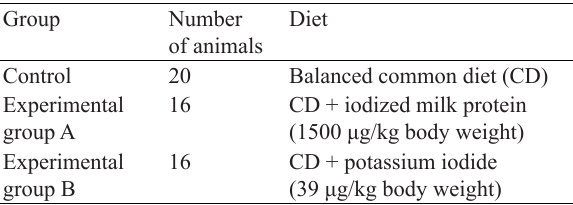
Table 1 Experiment scheme (stage I)